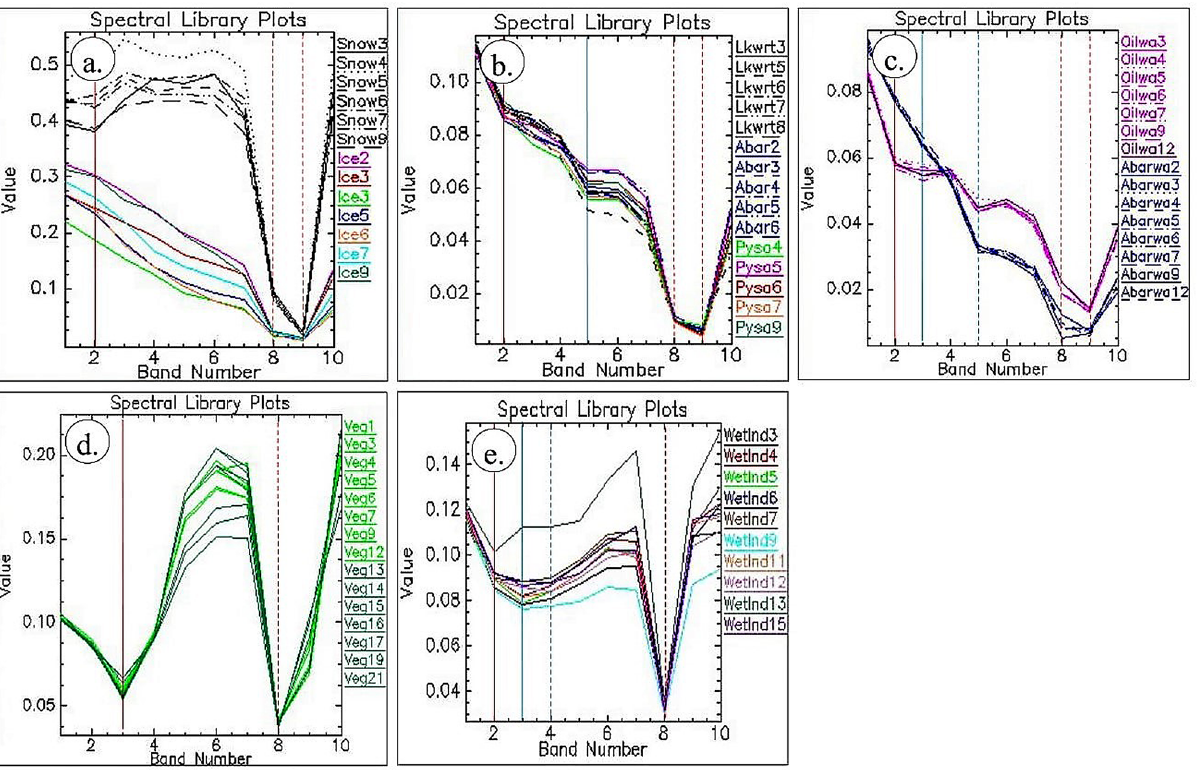
Figure 4. Sentinel-2 image spectra of ( a ) snow and ice, ( b ) water, ( c ) oil spill, ( d ) vegetation, and ( e ) wetland of the study area [ENVI 5.5 https ://www.harri sgeos patia l.com; https ://senti